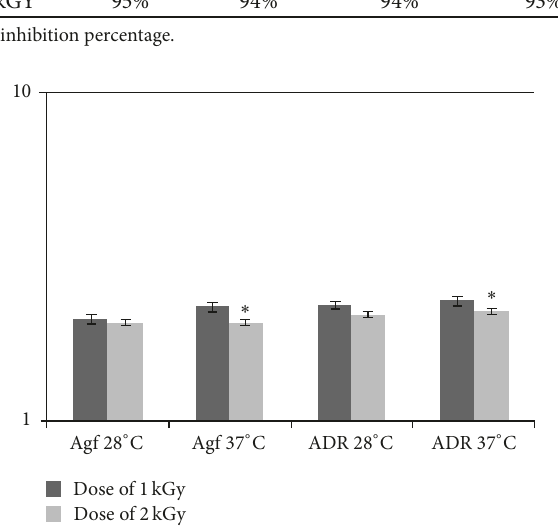
Figure 3: Effect of gamma radiation doses (1 and 2 kGy) on expression levels of agfD and adrA genes ( ∗ 𝑃 <